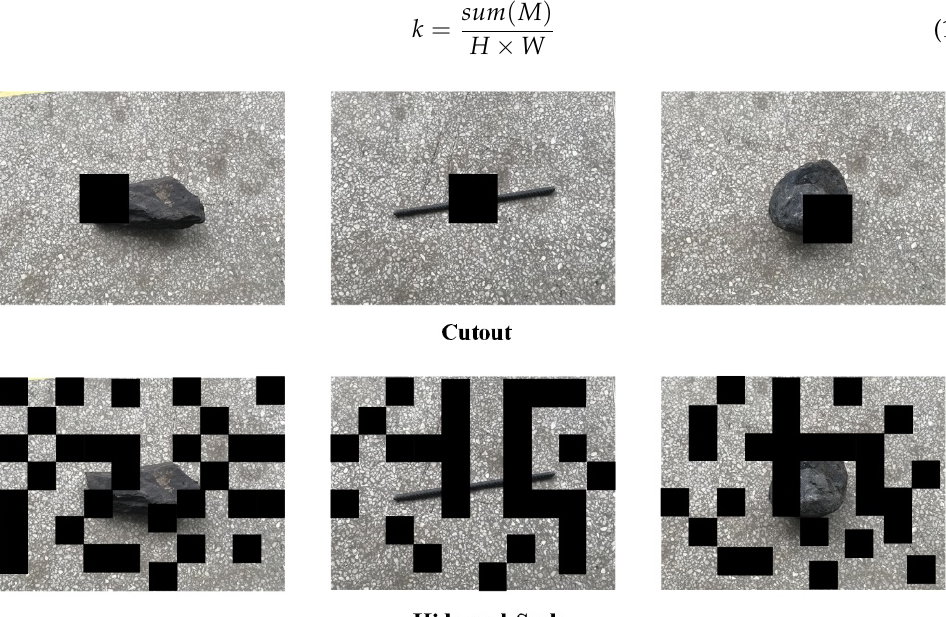
Figure 21. Image random erase processing.